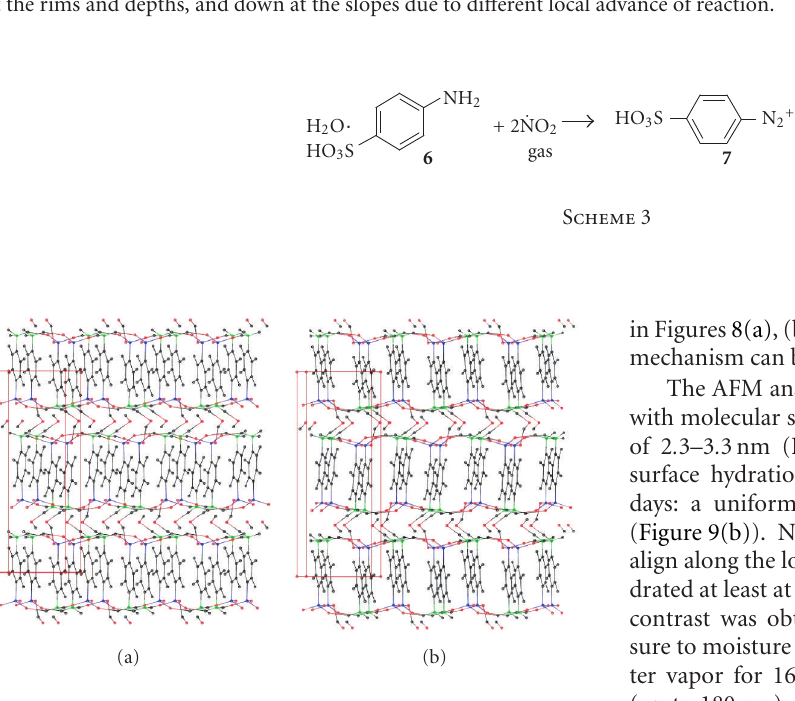
Figure 4: Simultaneous AFM (a) and SNOM (b) on a (110)-face of anthracene ( 3 ) (P2 1 /a) with some faults that were preexposed to ambient air; the slopes rarely exceed 20 ◦ (but 30 ◦ is also present); the SNOM image (b) indicates three types of contrast: normal at the flat sites, peak at the rims and depths, and down at the slopes due to di ff erent local advance of reaction.